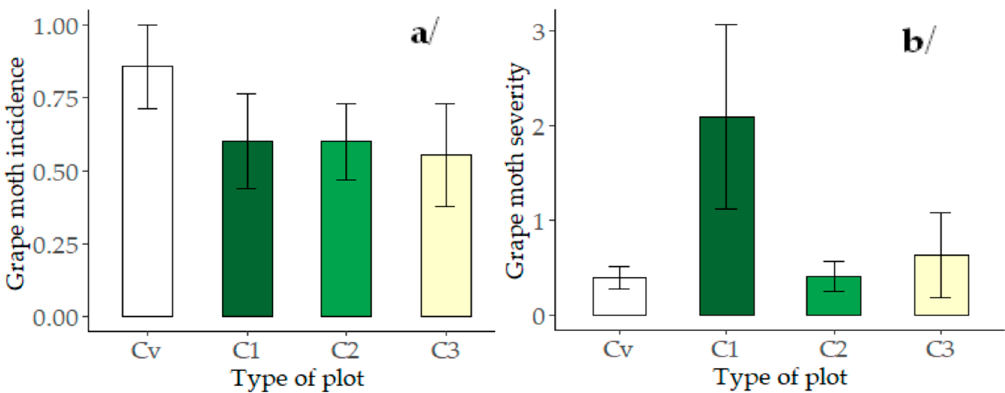
Figure 3. Mean grape moth incidence (frequency of infested plants ( a ), and severity in infected plots (number of larvae per bunch ( b ), in the plots, depending on their stage of conversion (Cv, conventional production; C1, C2, and C3 represent first, second, and third year of conversion, respectively). Error bars represent standard errors.